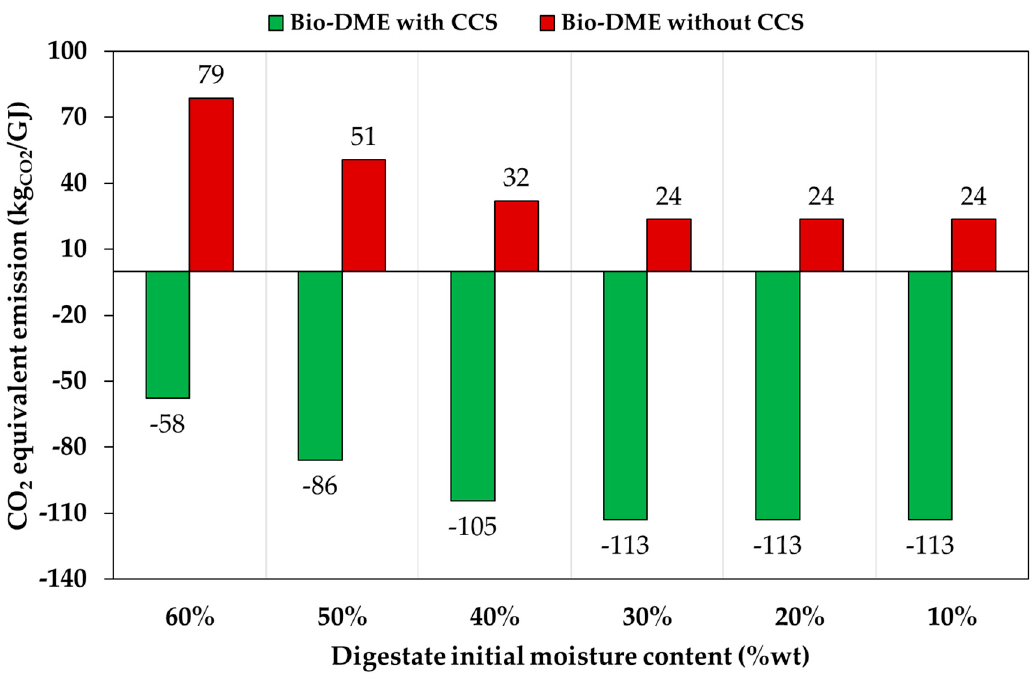
Figure 15. Effect of initial digestate moisture content on carbon dioxide emission of the proposed process plant for DME synthesis.